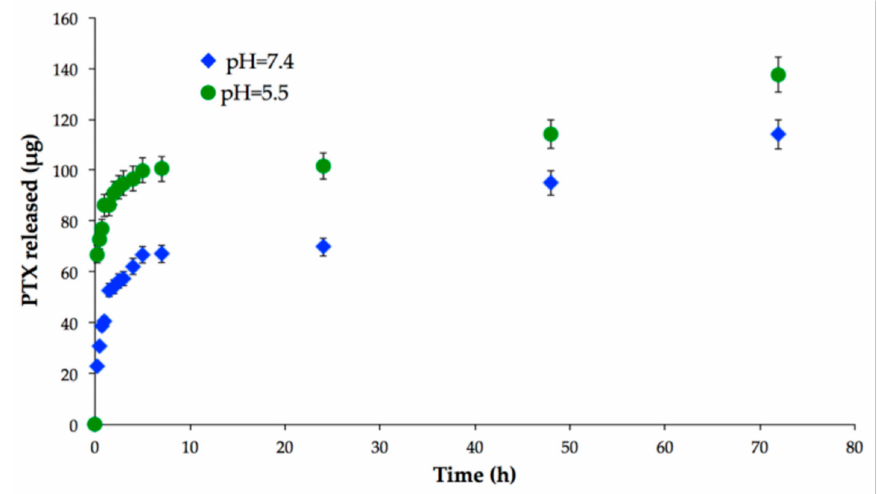
Figure 8. In vitro drug release of PTX-MN.